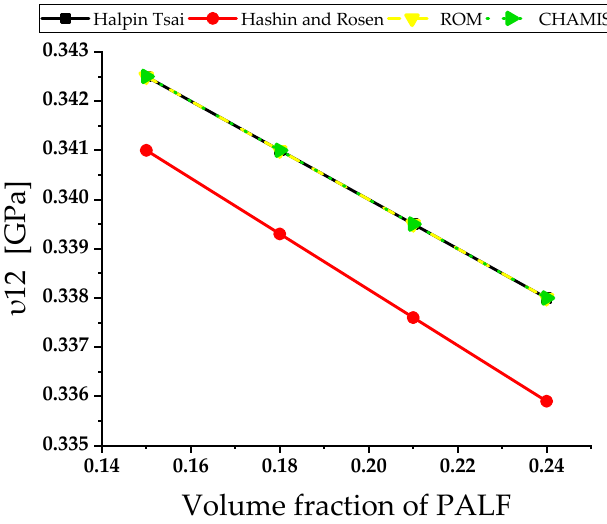
Figure 10. The Poisson’s ratio v 12 of PALF/epoxy in terms of V F . The first analytical part permitted us to select the analytical method that allows us to have mechanical properties that best converge with the experimental results. To forecast 𝐸 𝐸 (cid:2869)(cid:2869) and (cid:2870)(cid:2870) , the Halpin-Tsai approach was chosen. For it is ROM. A FEM approach is established and compared with the results of the analytical analysis in order to strengthen our prediction.